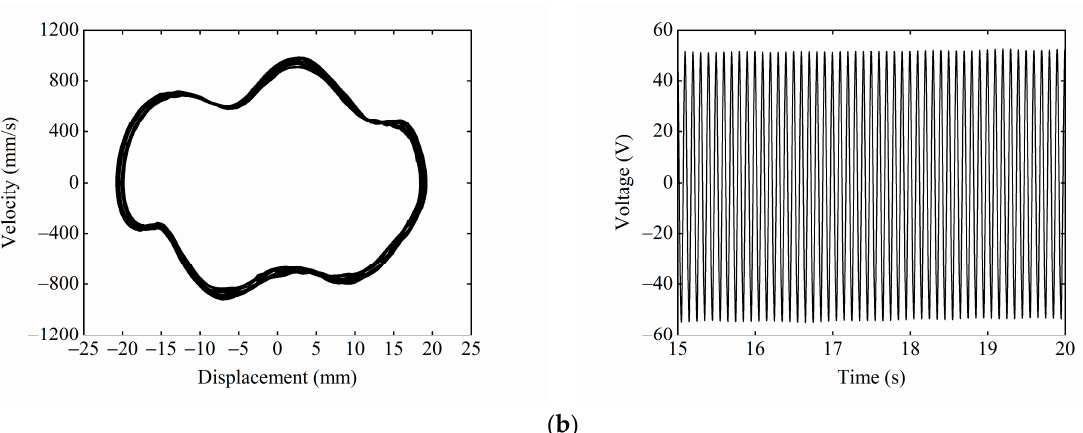
Figure 16. Experimental phase portrait and time–voltage diagram at different starting positions: ( a ) starting position is the central equilibrium position; and ( b ) starting position is the right-side equilibrium position.